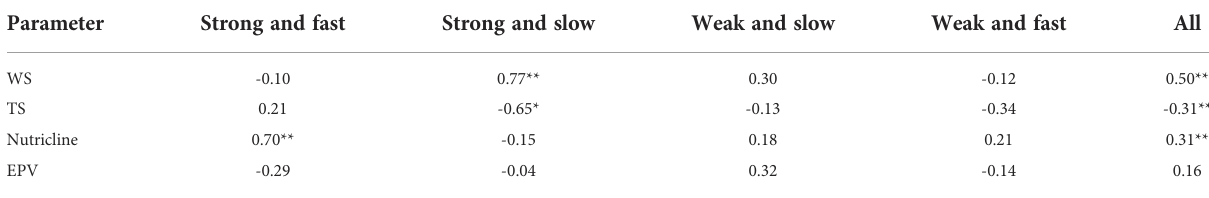
TABLE 3 The Partial correlation coef fi cients between the Chl_en and TC wind speed (WS), translation speed (TS), nutricline and Ekman pumping velocity (EPV) in the open sea region. Parameter Strong and fast Strong and slow Weak and slow Weak and fast All